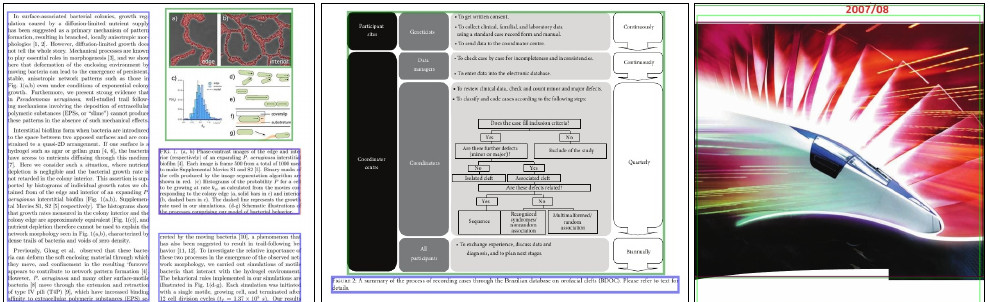
Figure 9. Different visual representations present in DocBank [19] and PublayNet [20] v/s IIIT- AR-13K [21]. Columns 1, 2, and 3 represent samples from DocBank, PublayNet, and IIIT-AR-13K, respectively. The colours blue and green represent paragraphs and figures, respectively. The vital distinction in the data distribution lies in the layout of the datasets. Figures and paragraphs are homogeneous in PublayNet and DocBank, whereas in IIIT-AR-13K, the samples follow a different layout, font-style, and document